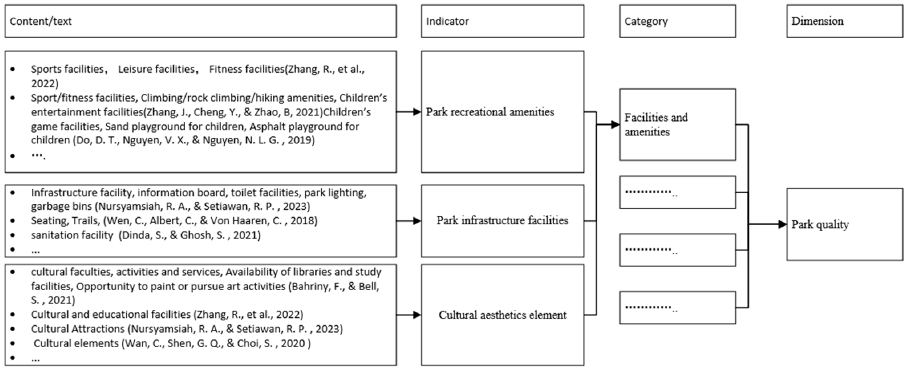
Figure 2. An illustrative example of how the indicators, categories, and dimensions emerged [1,5,15,17,18,41–43].